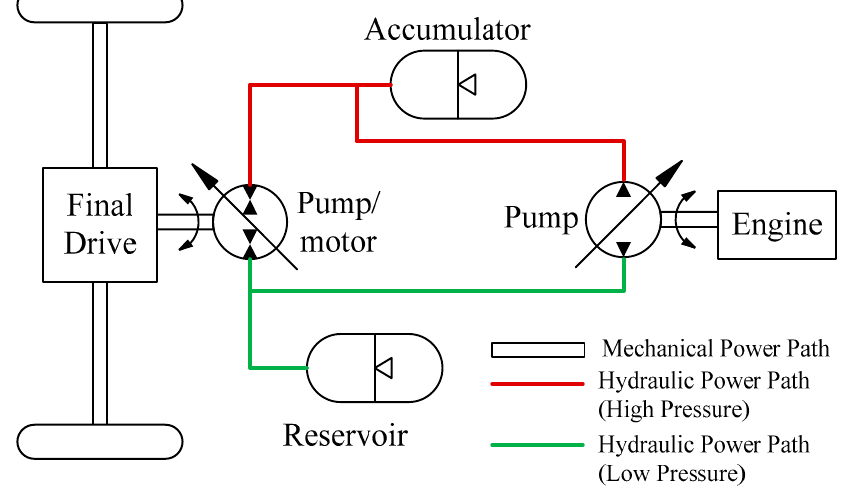
Figure 1. Schematic and Control Signal Paths of Series Hydraulic Hybrid Vehicle (SHHV).